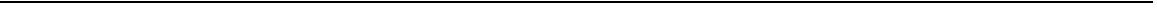
Figure 8 | Evidence for a pheromone-conducting tunnel in the SNMP1 ectodomain. ( a ) Representation of the SNMP1 ectodomain tunnel, shown as a slice through the body of the protein. Charged residues on the tunnel surface are coloured (red: negative; white: neutral; blue: positive). Putative tunnel bottleneck residues (T274, L439 and V353, green) and a control tunnel-lining residue (A401, yellow) are highlighted. ( b ) ‘Top’ cross-sectional view (at the approximate level of the dashed line in ( a ) of the SNMP1 tunnel, coloured as in Fig. 7a. ( c ) Analysis of the rescue properties of SNMP1 site-directed mutants in which predicted tunnel-lining residues are substituted with larger residues. Left: immunostaining with a -SNMP1 on antennal cryosections. Scale bars, 20 m m. Centre: representative traces of electrophysiological recordings of OR67d neurons (male flies) stimulated with 10% cVA. Right: mean neuronal responses ± s.e.m. There are significant statistical differences in neuronal responses due to genotype for 0.1, 1 and 10% cVA (Kruskal–Wallis, P o 0.001). Significant differences in cVA responses of the different genotypes compared with full-length SNMP1 rescue are indicated; *** P o 0.001. ( d ) Analysis of the localization properties of the indicated SNMP1 site-directed mutants using the integrated density ratio of SNMP1 and ORCO immunostaining quantified in OR67d-expressing sensilla. Mean ± s.d. in a scatter dot plot is shown. n is shown in parenthesis below the labels on the x axis. There are significant statistical differences in localization properties due to genotype (Kruskal–Wallis, P o 0.005). Significant differences of the different genotypes compared with full-length SNMP1 rescue are indicated; * P o 0.05). ( e ) Concentration–response curves of OR67d neurons to cVA in the indicated rescue genotypes. Curves were fitted using a log versus response-variable slope model with Prism-GraphPad. Mean responses ± s.e.m. are plotted. n is shown in parentheses next to the legend labels. ( f ) Left: representative traces of electrophysiological recordings of OR67d neurons lacking OR67d and endogenous SNMP1, and ectopically expressing HR13 in the absence or presence of transgenically expressed SNMP1 proteins, stimulated with 10% ( Z )-11-hexadecenal. Genotypes: UAS-HR13/UAS-SNMP1 xxxx ;Or67d GAL4 ,snmp1 1 /Or67d GAL4 ,snmp1 2 (‘xxxx’: wild type or mutant variant of SNMP1). Right: mean neuronal responses ± s.e.m. There are significant statistical differences in neuronal responses to ( Z )-11-hexadecenal due to genotype (Kruskal–Wallis, P o 0.0001). Significant differences in cVA responses compared with ‘HR13 þ SNMP1’ are indicated in the figure; * P o 0.05, ** P o 0.01, *** P o